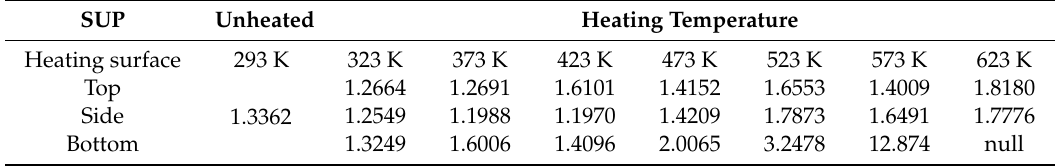
Table 6. The uniformity of the three heating positions at the di ff erent heating